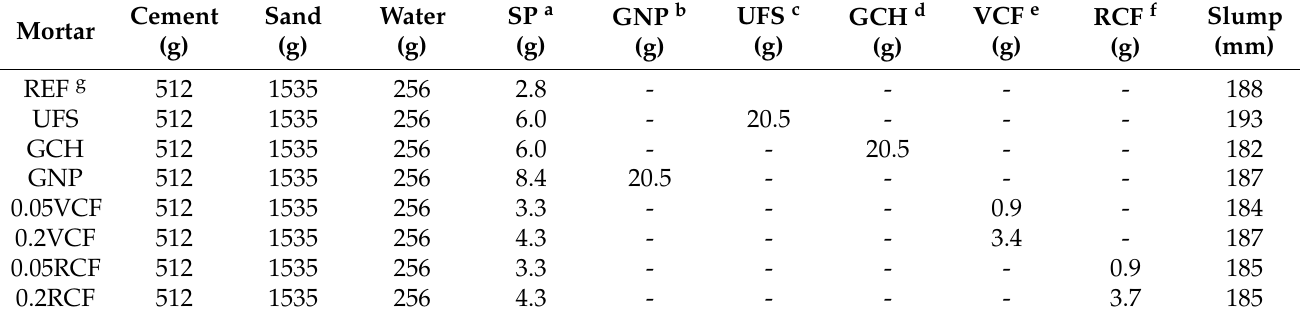
Table 1. Mix design of mortars and slump value—the first part of the experimentation.